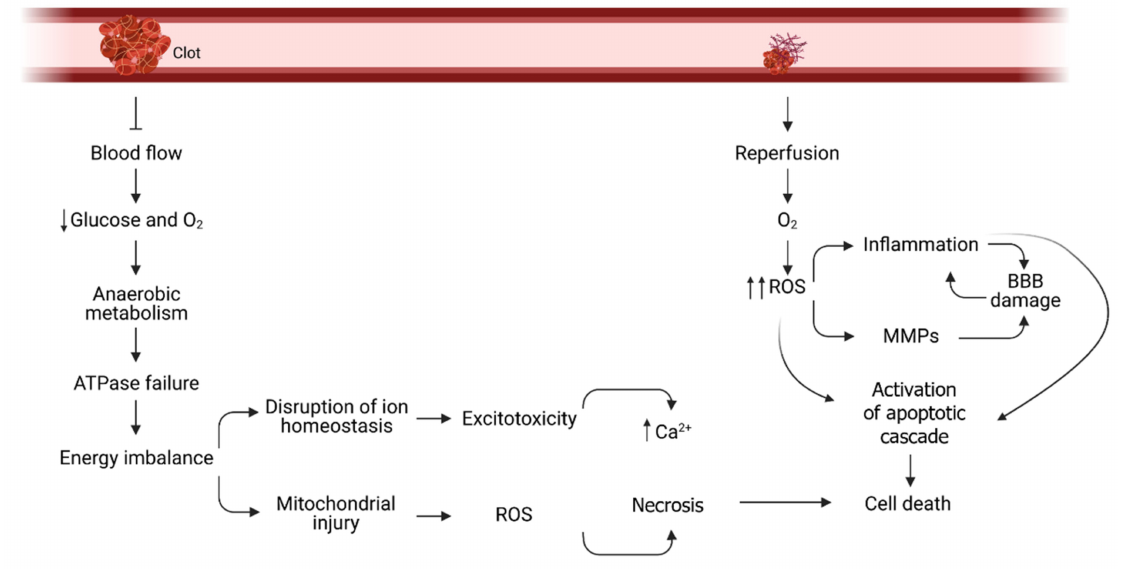
Figure 2. Ischemic cascade during stroke. Hypoperfusion of a brain area during stroke causes a rapid energy imbalance. Low ATP levels cannot maintain ionic homeostasis and mitochondrial function, which ultimately lead to cell death in the ischemic core. After reperfusion, overproduction of Reactive Oxygen Species (ROS) triggers post-ischemic inflammation and the leakage of the Blood Brain Barrier (BBB) that amplifies cytotoxicity at the penumbra. Abbreviations: matrix metalloproteinase